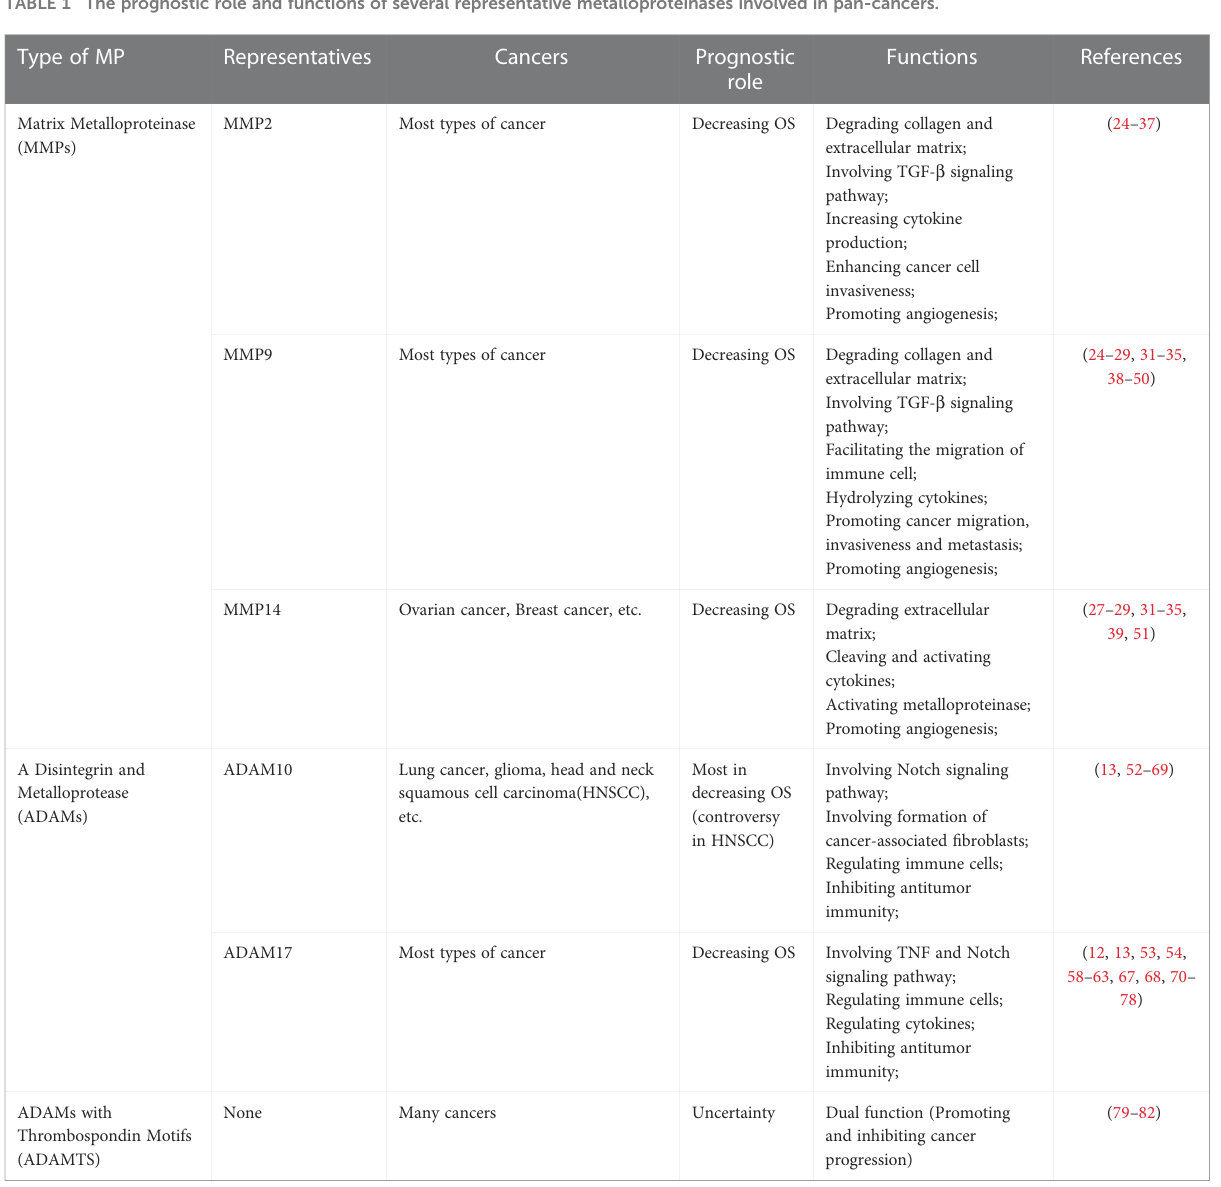
TABLE 1 The prognostic role and functions of several representative metalloproteinases involved in